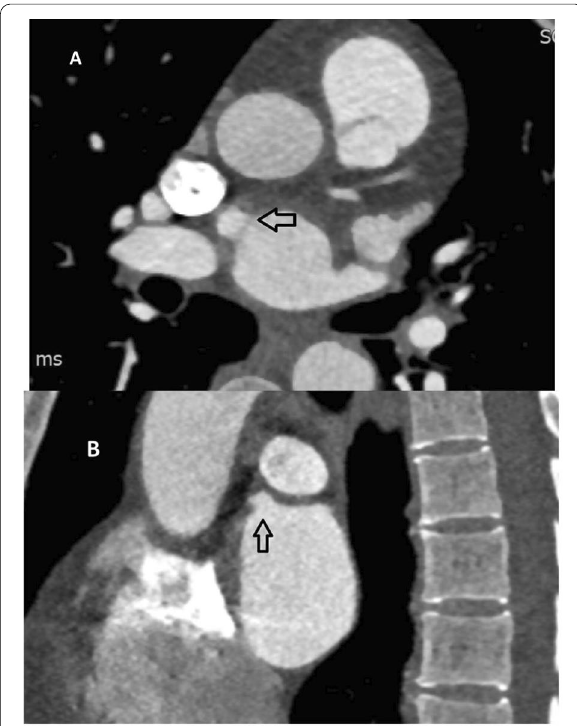
Fig. 1 Axial ( A ) and sagittal ( B ) images of the cystic diverticulum in the anterosuperior location of the left atrium are observed